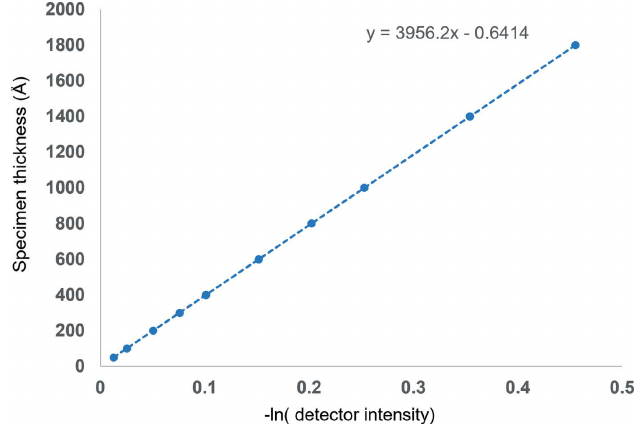
Figure 3 Coarse-grained all-atom solvent model in combination with the inelastic scattering factor for plasmons we derived produces amplitude losses via the complex potential that do not need to be scaled post hoc . The slope is a readout for the inelastic (single-scatter) mean free path in our simulated